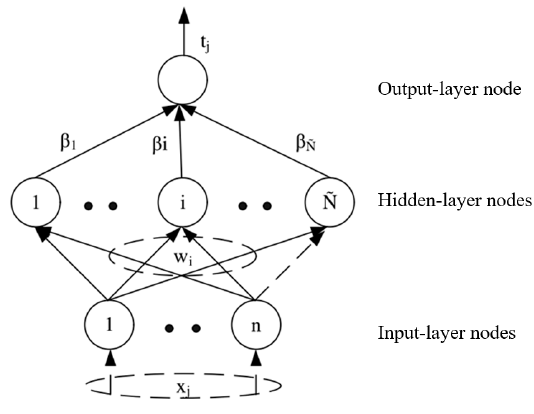
Figure 4. Model of ELM neural network.